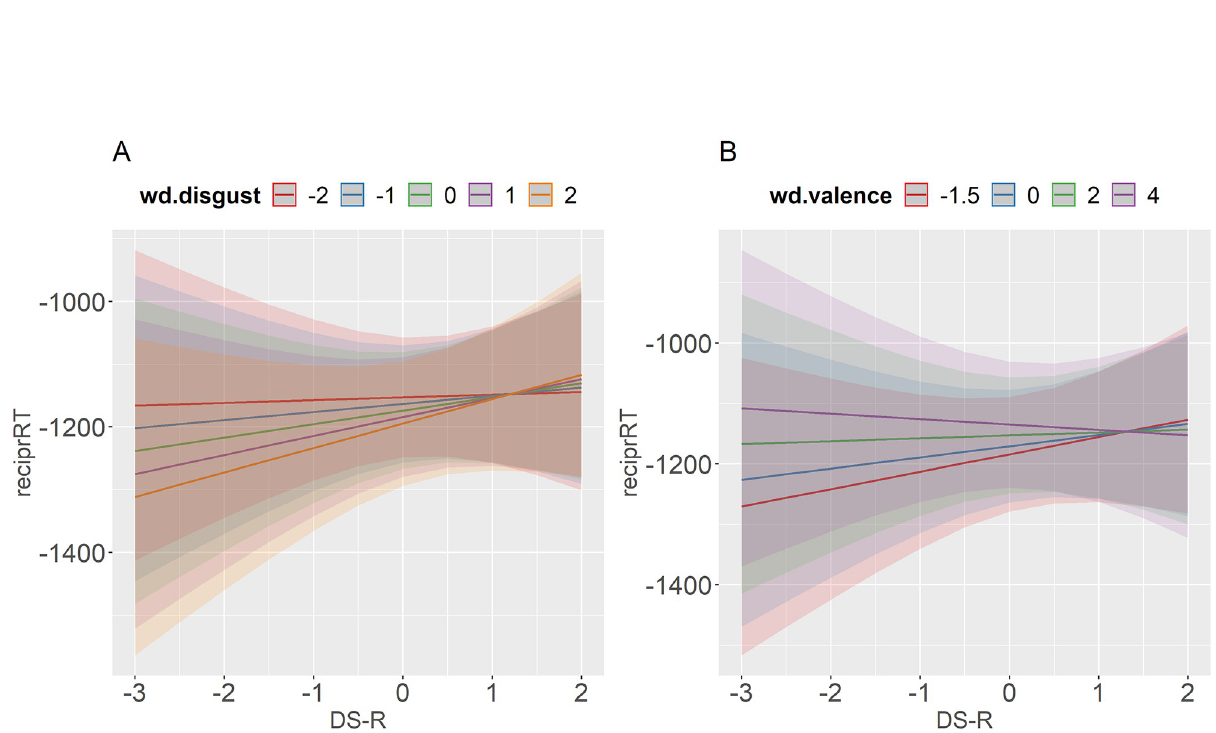
Fig 6. Predicted values (marginal effects) of the interaction between DS-R and word disgust (A) and DS-R and word valence (B) with reciprocally transformed RTs as a dependent variable. Bigger negative numbers correspond to shorter lexical decision times.